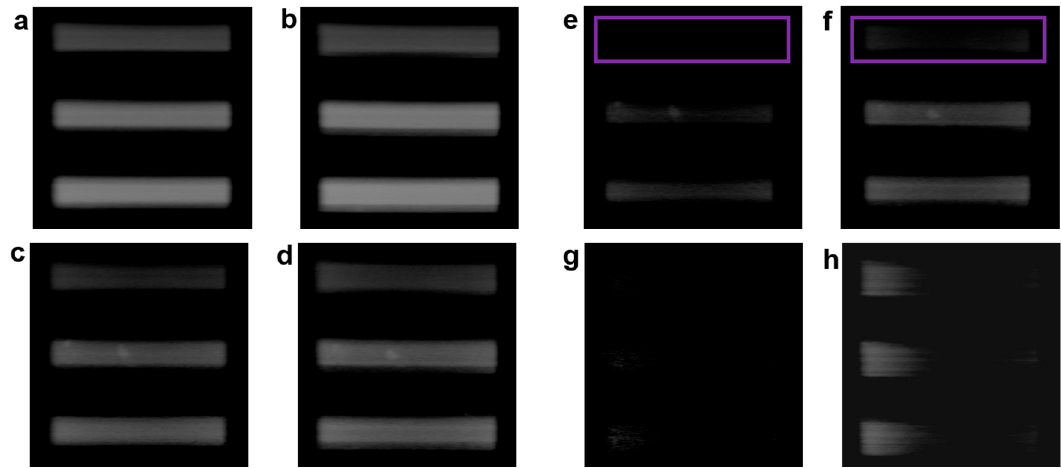
Figure 4. Relative intensity of the reflected light images from the target by line scanning with near-infrared laser (780 nm) Airy and Gaussian beams. ( a ) and ( b ) are images of the reflected light for the Gaussian and Airy beams without media, respectively; ( c ) and ( d ) are images for the Gaussian and Airy beam at 150 μ m thick water/milk mixture, respectively; ( e ) and ( f ) are images for the Gaussian and Airy beam at 300 μ m thick water/milk mixture, respectively; ( g ) and ( h ) are images for the Gaussian and Airy beam at 450 μ m thick water/milk mixture, respectively.